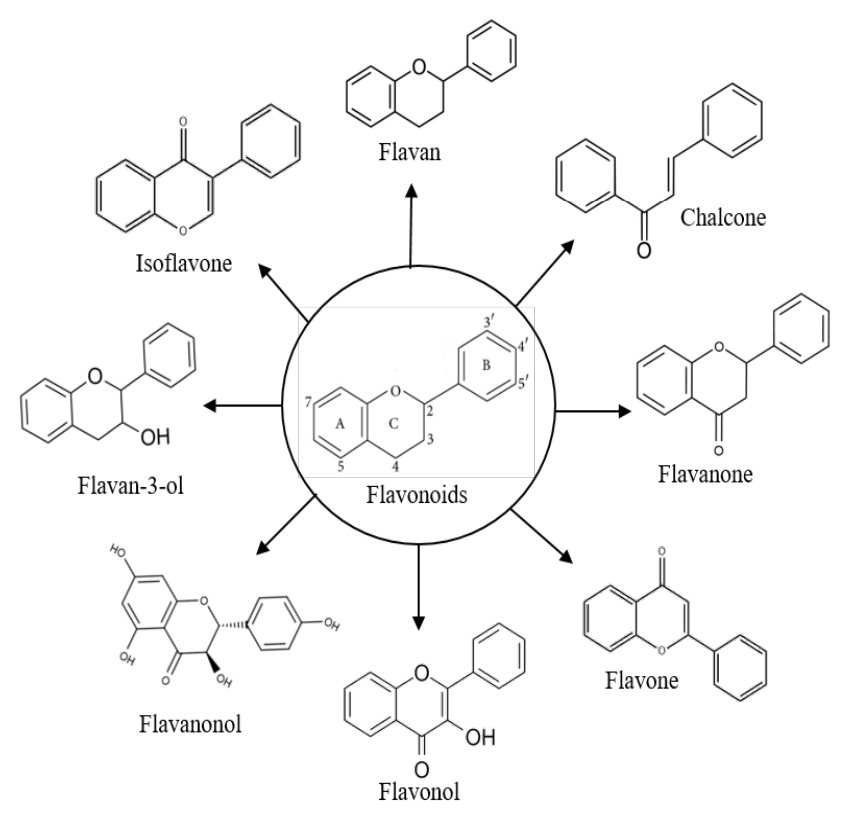
Figure 3. Chemical structures of sub-groups of flavonoids, showing that the various sub-groups are related to the oxidation and substitution of the heterocyclic C ring, while individual compounds in a sub-group vary depending on the substituents attached to the A and B rings.